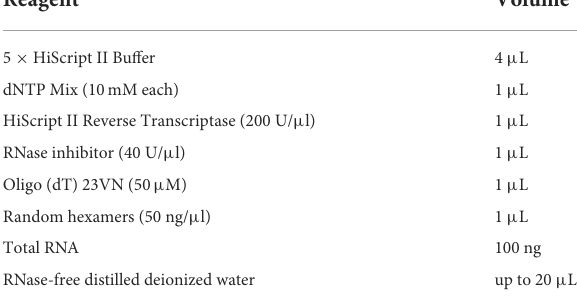
TABLE 1 Reverse transcription reaction system details.